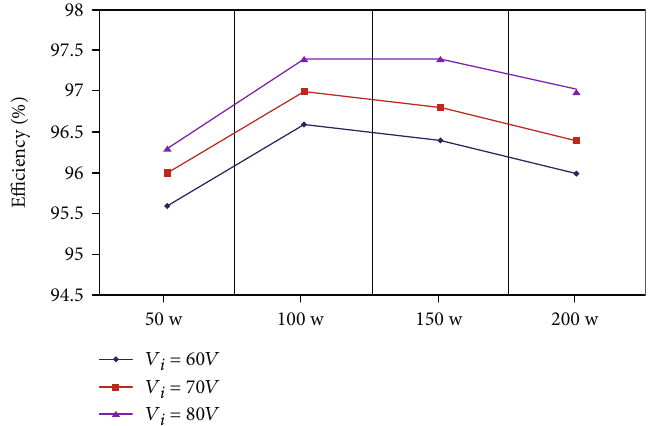
Figure 14: E ffi ciency curves.